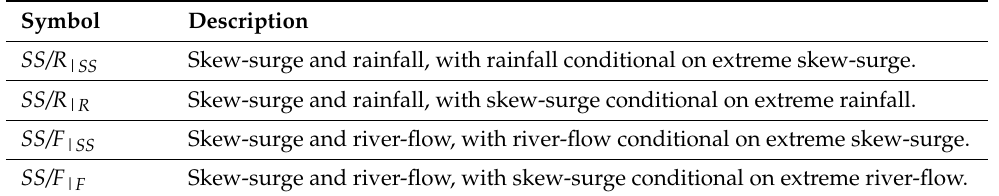
Table 1. Description of the four dependence cases analyzed.